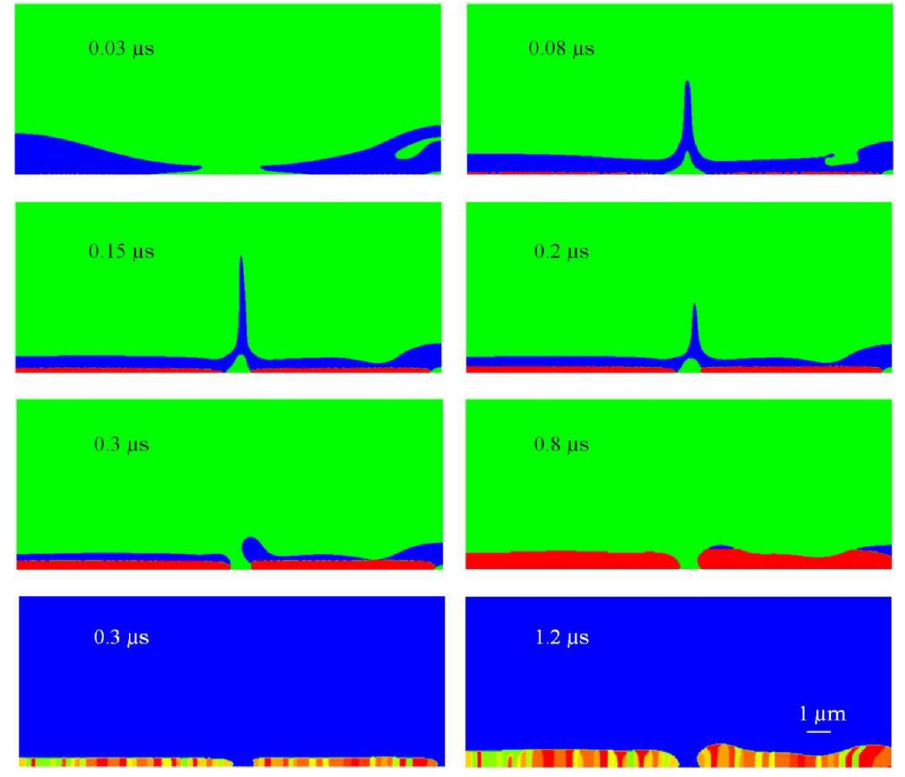
Figure 13. Effect of void size in the hollow droplet.